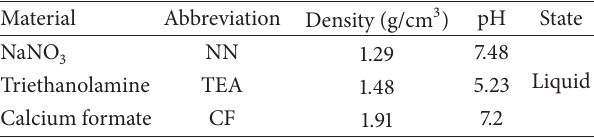
Table 4: Physical properties of early strength materials.